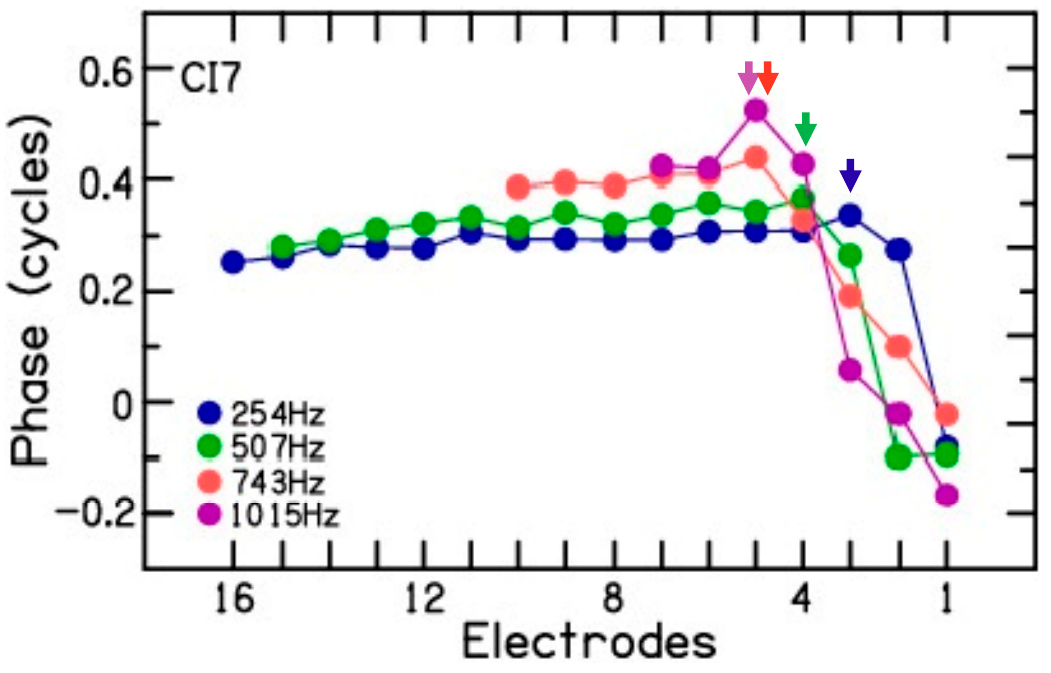
Figure 4. Example of phase in an electrode scan for patient CI7. The phase changes show two regions. In the basal cochlea, the phase changes are minimal, consistent with a fast - traveling wave through these regions or approaching the responding hair cells. In the apical region, the phase accumulation increases, consistent with a slowing traveling wave. There is a systematic relationship between the location stimulus frequency and electrode where the steeper slope begins.